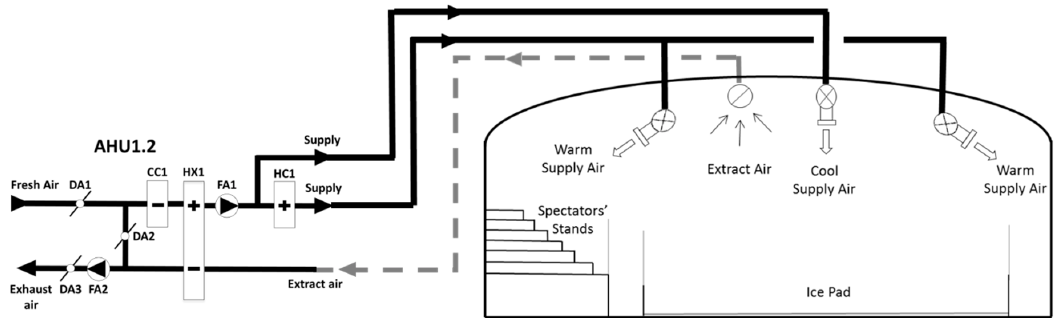
Figure 4. Schematic view of AHU1.2 and its corresponding air distribution system.